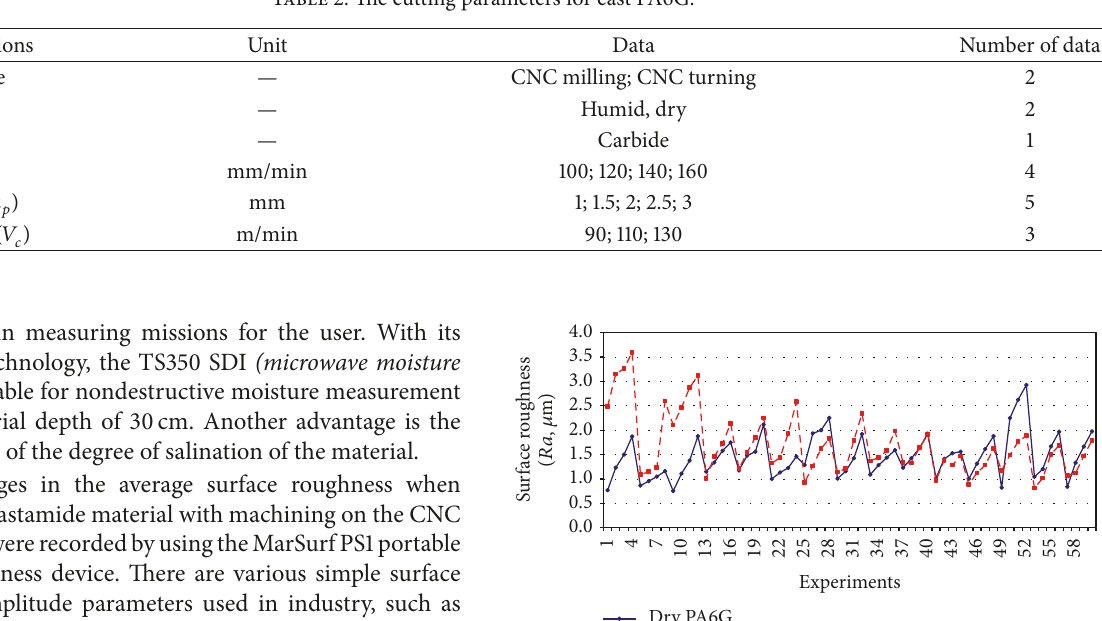
Table 2: The cutting parameters for cast PA6G.